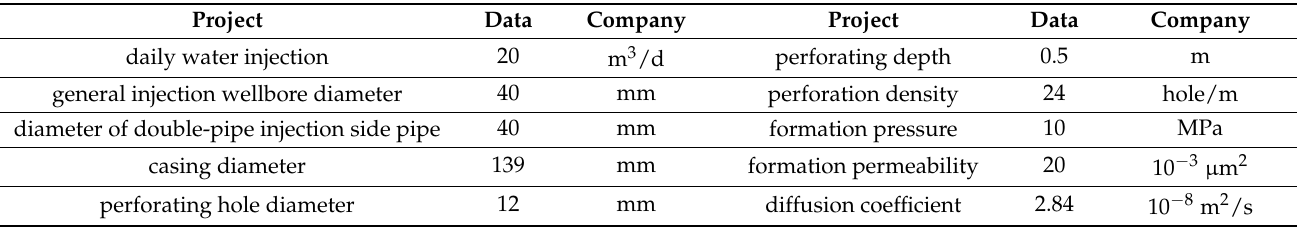
Table 1. Parameters required for